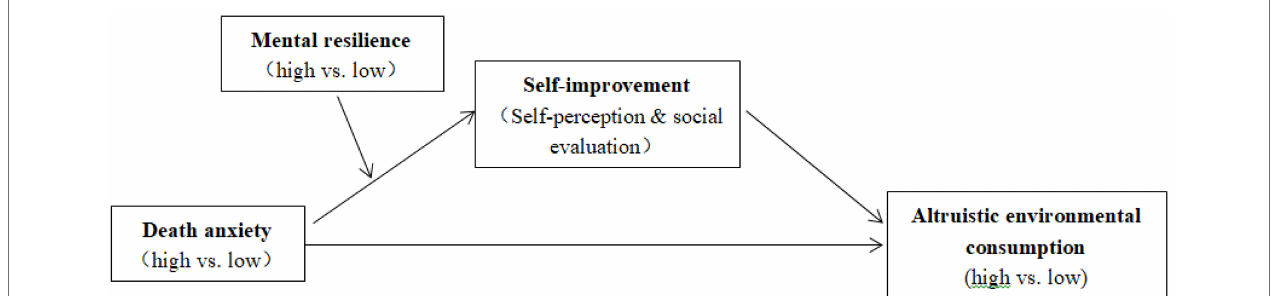
FIGURE 1 | Research